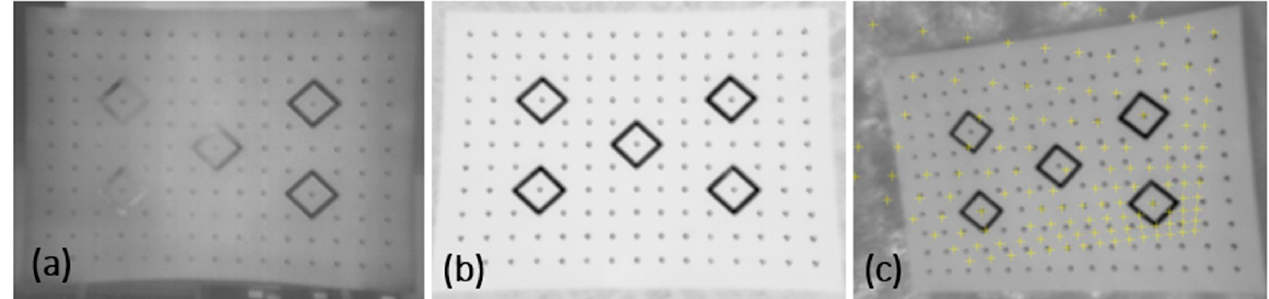
Figure 16. Thermal contrast of thermograms for: ( a ) vertical; ( b ) horizontal orientation of the calibration board; ( c ) incorrect target identification at a too large camera tilt angle.